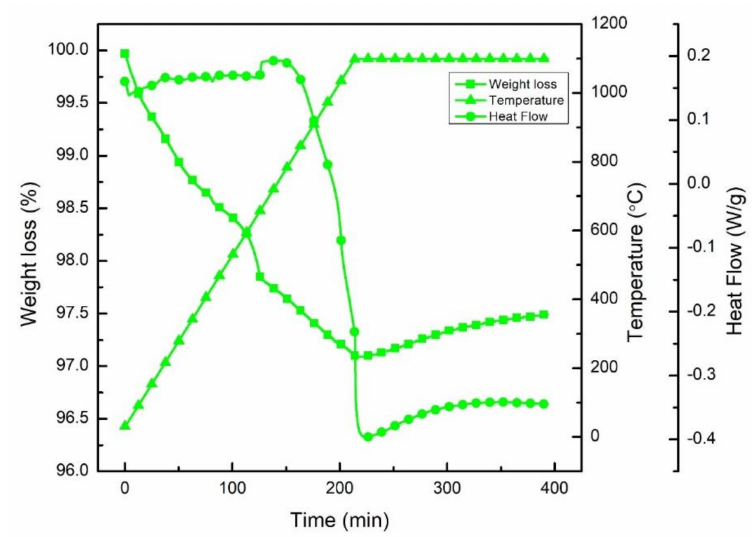
Figure 4. TGA/DSC curves of 0BMN sample during sintering at 1100 ◦ C for 3 h in the